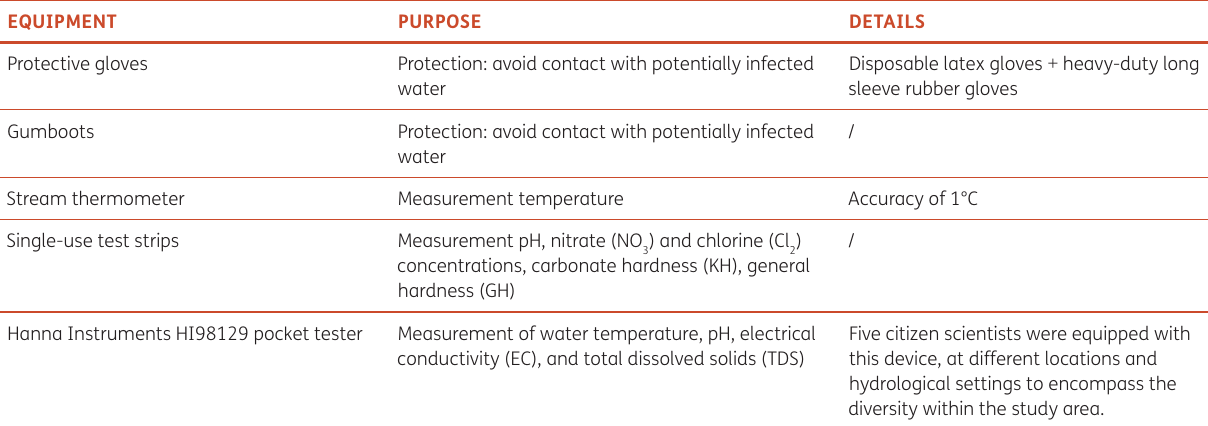
Table 1 Overview of the sampling equipment of the citizen scientists. In addition to the equipment mentioned here, every citizen scientist received a personal notebook to record any information they considered